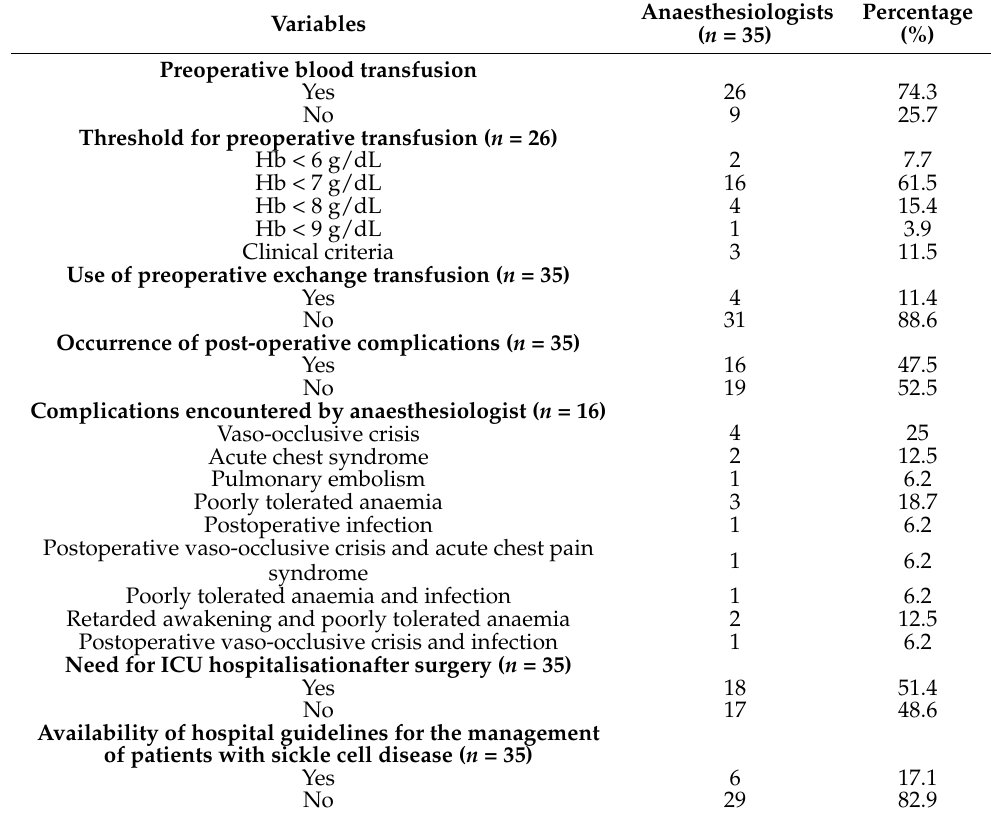
Table 3. Perioperative blood transfusion, postoperative complications encountered and need for ICU